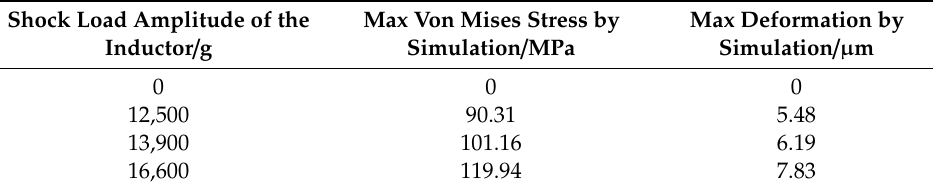
Table 1. The simulated stress and deformation of the inductor under shock.